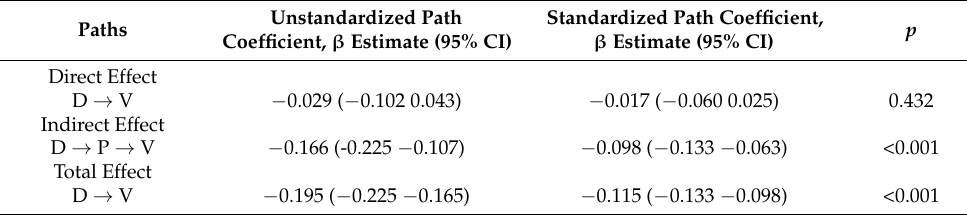
Table 1. Direct, Indirect, and Total Effects of Distrust on Vaccine Uptake.